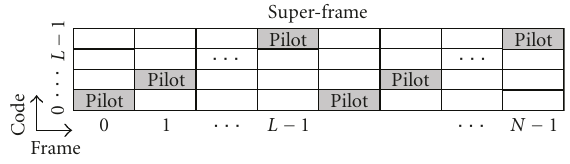
Figure 4: Super-frame format with pilot